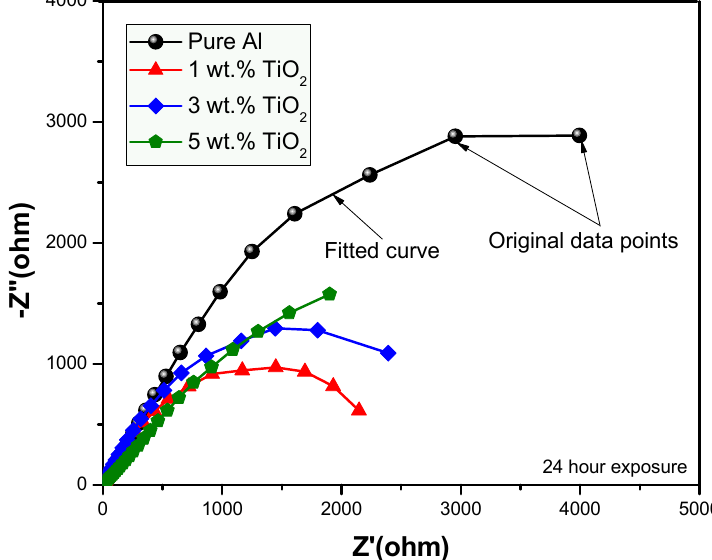
Figure 6. EIS for composite samples exposed for 24-h in 3.5% NaCl solution.